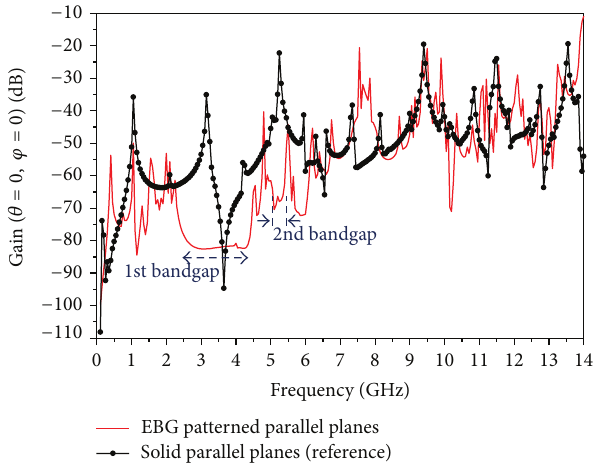
Figure 11: Radiation gain versus frequency from two setups defined in the caption of Figure 6 in perpendicular direction to the planes.